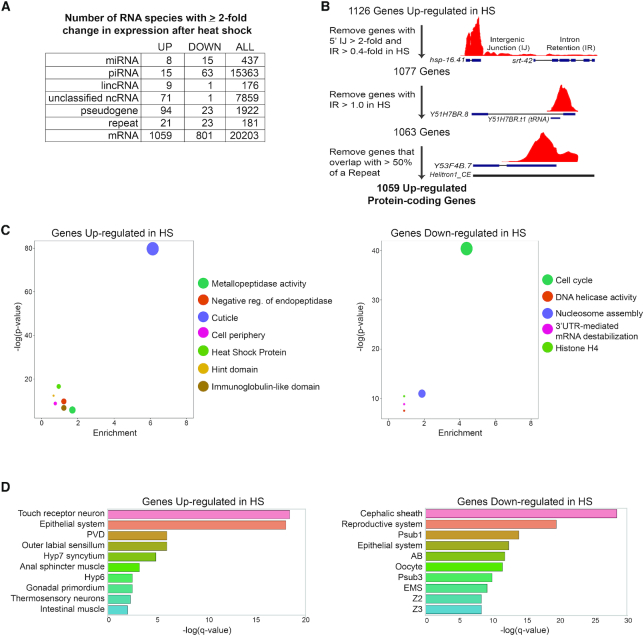
HS alters the expression of coding and non-coding RNAs. (A) Small RNA-seq and stranded paired-end RNA-seq were used to analyze changes in RNA expression in Caenorhabditis elegans shifted from 20°C (control, CTRL) to 35°C (HS) for 4 (RNA-seq) or 6 h (smRNA-seq). The numbers of differentially expressed genes in each RNA category are indicated. ‘ALL’ refers to the total number of annotated genes in each class. (B) Strategy used to filter out false positive upregulated mRNAs. See ‘Materials and Methods’ section for further details; codes used for filtering are available at https://github.com/wschrein. (C) DAVID Functional Annotation Clustering of Genes up- and downregulated in response to HS (41). Representative members of each cluster with an enrichment score > 2 are shown. Size of dot corresponds to number of genes in each cluster. (D) TEA for genes up- and downregulated in response to HS. TEA was performed using the Wormbase TEA tool (45). Abbreviations: PVD—Sensory neuron (polymodal nociceptive for mechanosensation and thermosensation), Hyp7—entire syncytium of hyp7, Hyp6—Cylindrical hypodermal syncytium in head, Psub1—Embryonic founder cell, AB—Embryonic founder cell, Psub3—Embryonic founder cell, EMS—Embryonic Cell, Z2—Germ line precursor cell, Z3—Germ line precursor cell.